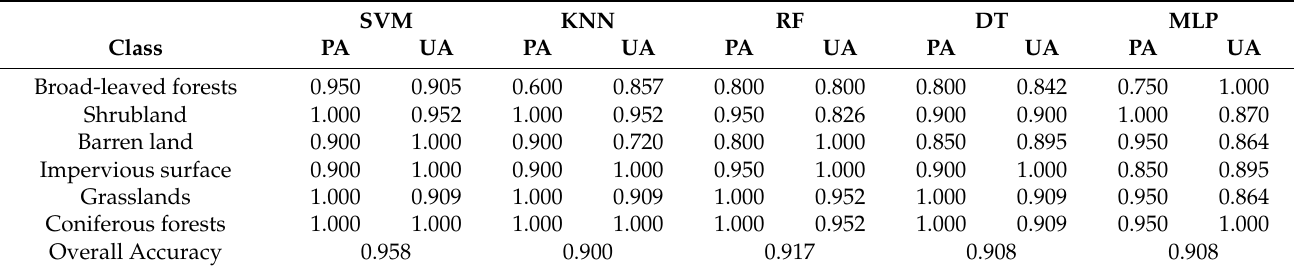
Table 6. Forest land resource information accuracy of five classifiers (SVM, KNN, RF, DT and MLP) based on the